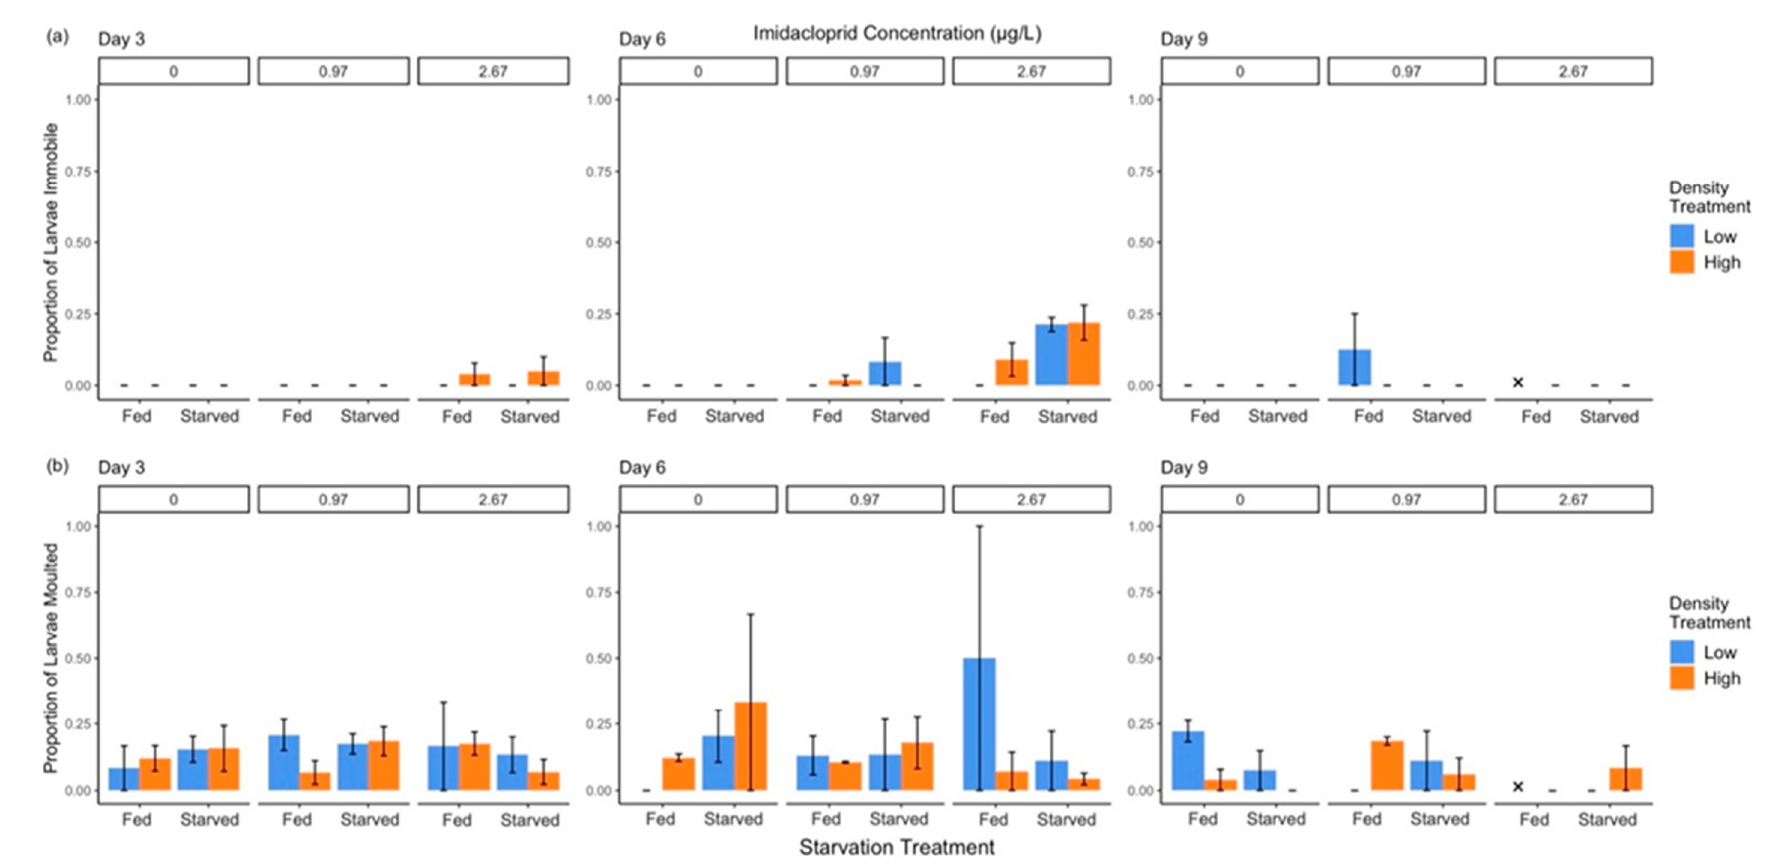
Figure 2. Responses of ( a ) immobility and ( b ) moulting frequency to the three imidacloprid treatments at the two mayfly nymph densities (10 and 20) and in the two starvation treatments (Starved = starved for five days immediately prior to the imidacloprid exposure period). Bars represent means ± SEs. In cases where bars are missing, ‘ × ’ represents a treatment group in which all mayflies had died in all replicates—i.e., no sublethal responses were measured—whereas ‘_’ represents a zero value. See Table 4 for statistical results.